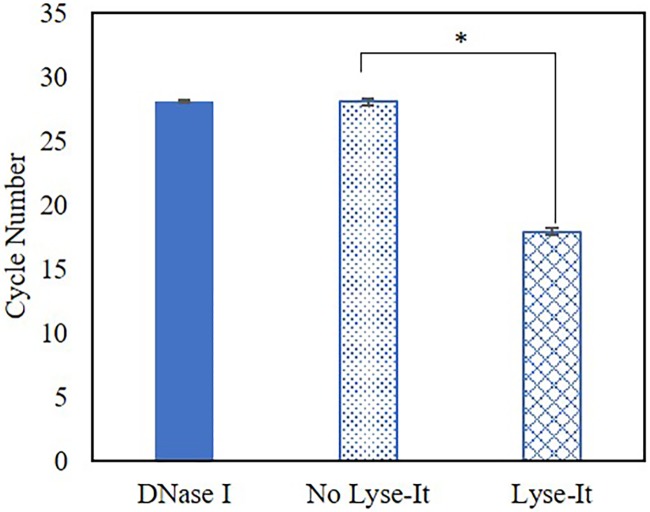
qPCR cycle number for amplified V. cholerae DNA before and after a 10-minute exposure to DNase I without microwave irradiation (DNase I), after 50% power 60 seconds standard microwave irradiation (No Lyse-It) and after 50% power, 60 seconds with Lyse-It (Lyse-It).A decrease in cycle number is seen with Lyse-It because the V. cholerae DNA is intact as compared to being chewed-up by intact DNase I. * = p = 0.001.